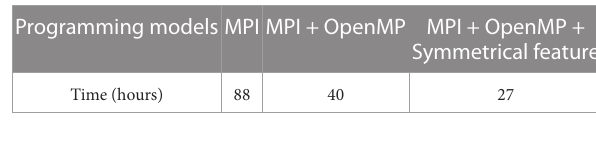
TABLE2 Thecalculatingtimeandrelativeefficiencyofinvertingthe normalequationmatrix ( N 58077×58077 )